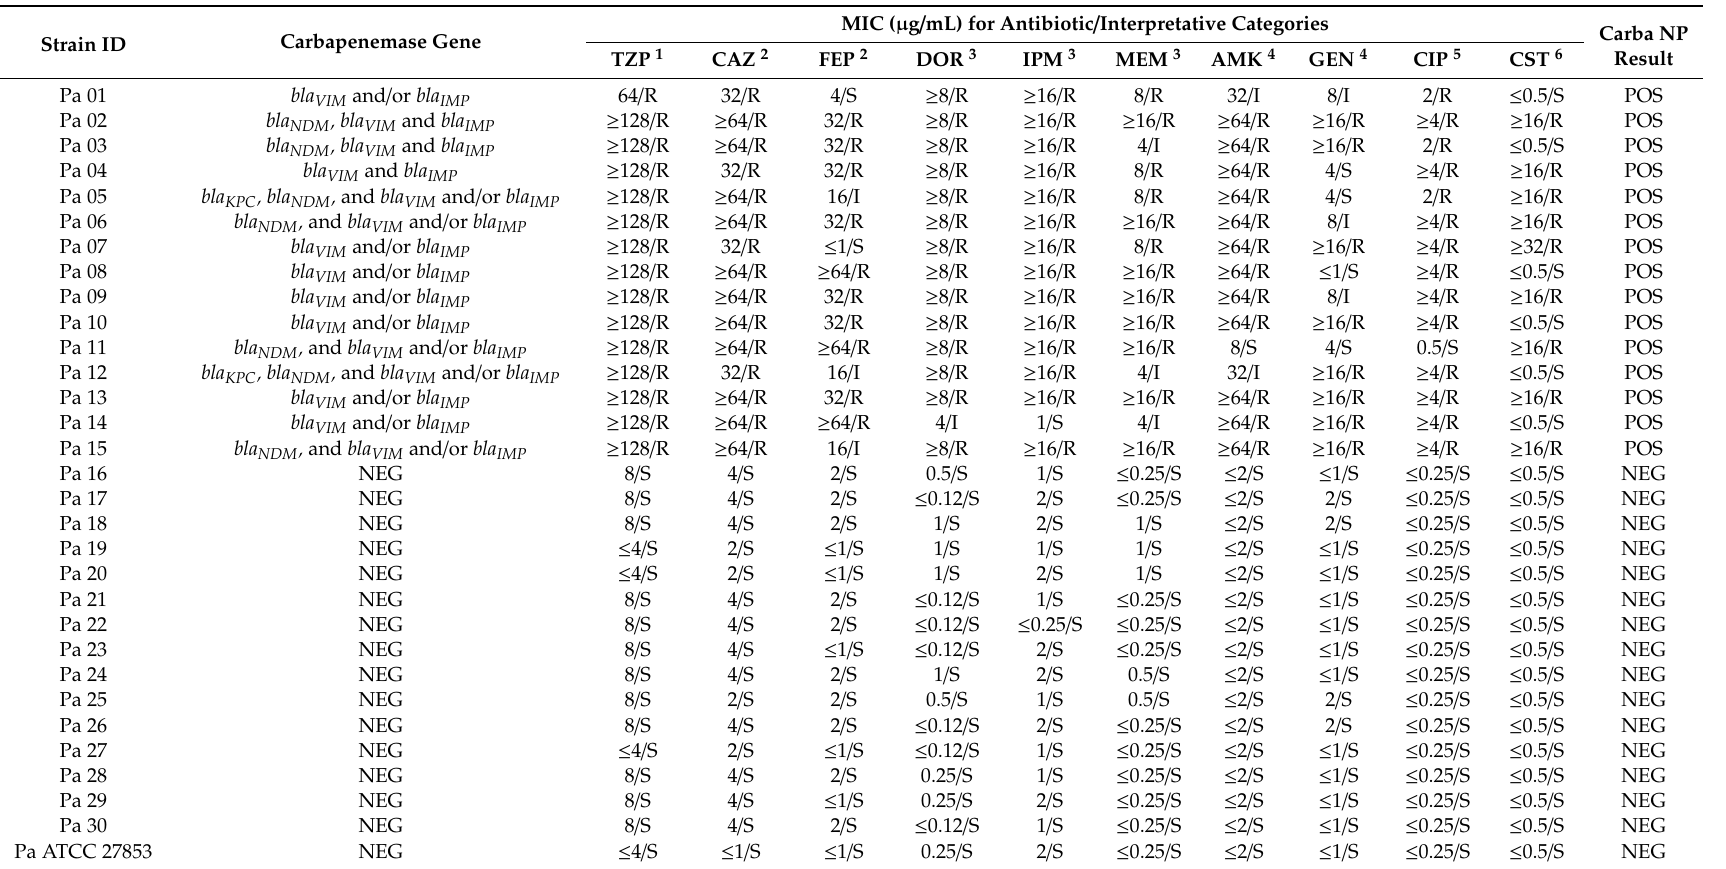
Table 2. Antimicrobial susceptibility and resistance profiles of wild-type and multidrug-resistant strains of P.